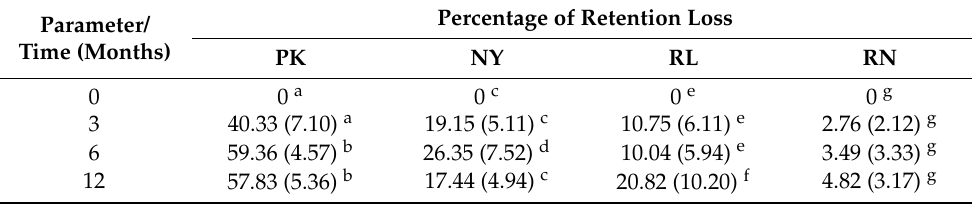
Table 3. Mean and SD of Percentage of retention loss of tested groups at 0, 3, 6, and 12 months artificial